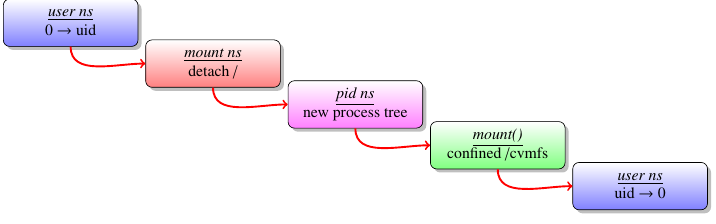
Figure 3. In order to enable Fuse mount points to be private to a namespace, a certain set of names- paces has to be created in order. In the process, mounting takes place as “fake root user”, i.e. as a privileged user whose actions are confined to a namespace. Consequently, mount points created within a namespace are invisible to processes outside the